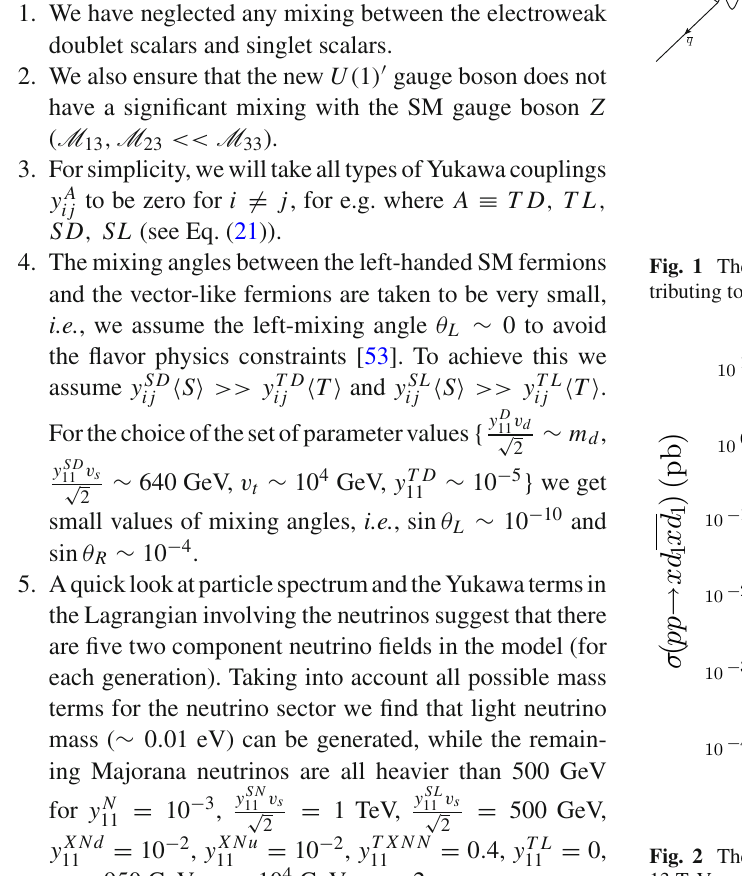
Fig. 2 The pair production cross section of xd 1 at the LHC with 13 TeV as a function of M xd